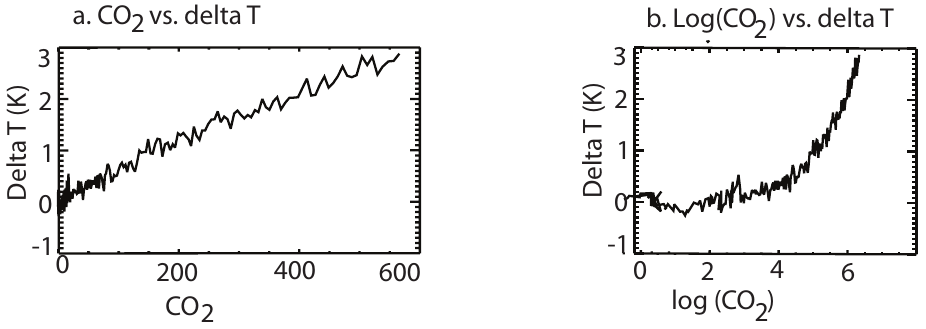
Fig. A6. The modeled relationship between temperature and carbon dioxide in the BASE1 case (a) , and plotted instead using a log relationship (b)